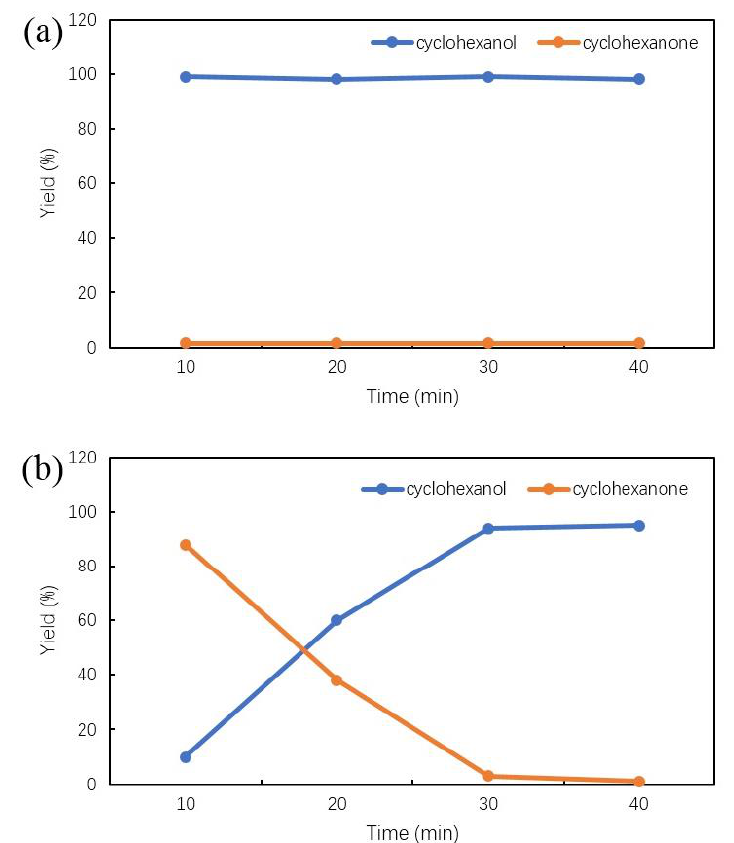
Figure 5. Time course of the yield of cyclohexanol carried out in the transfer hydrogenation ( a ). Time course of the yield of cyclohexanone carried out in the transfer hydrogenation ( b ). Table 5. Distribution of products with 20% Ni/CNT in isopropanol.